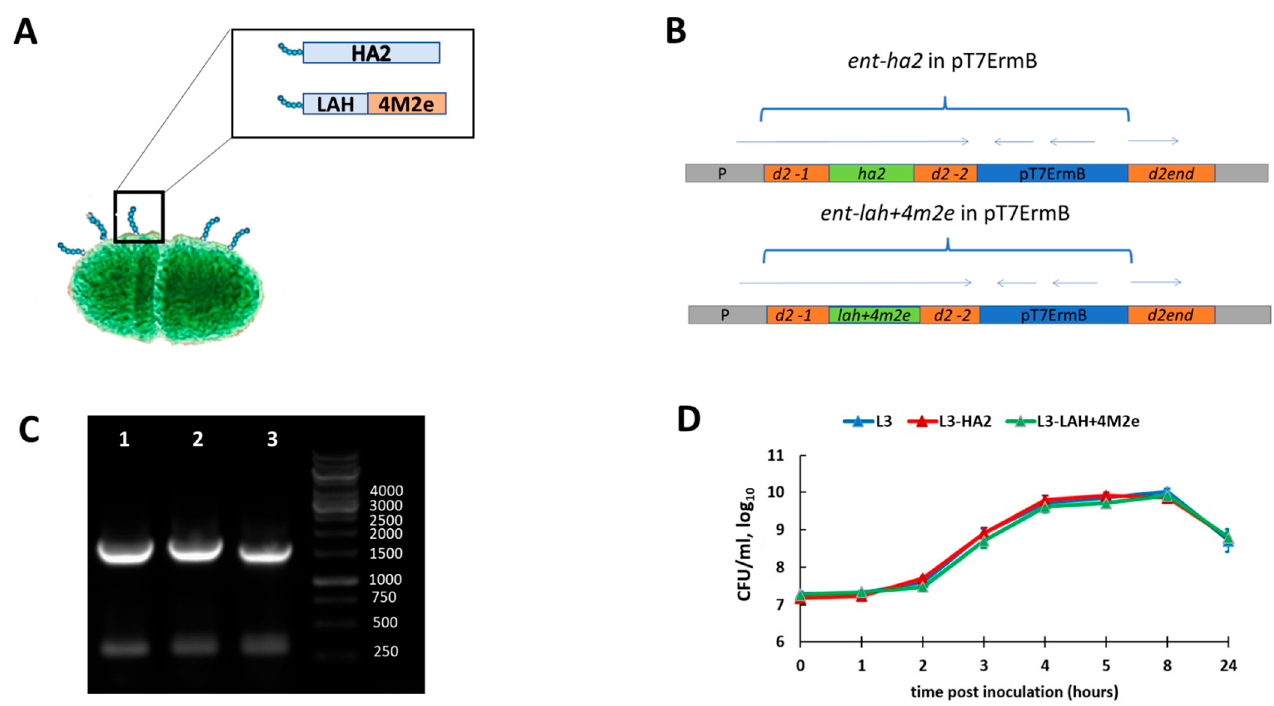
Figure 2. Generation and characterization of the live probiotic influenza vaccine candidates. ( A ) Schematic presentation of the chimeric E. faecium proteins. ( B ) Integration scheme of the plasmid pT7ermB with the ent-(lah+4m2e) into the chromosome of the strain E. faecium L3. P is the promoter of the gene d2; d2-1 is a region of the d2 gene encoding for N-(lah+4m2e) terminal part of D2 protein; d2-2 is a region of the d2 gene encoding for central portion of D2 protein; LAH and LAH+4M2e are DNA fragments encoding conserved influenza virus epitopes; d2-end is the end of the d2 gene encoding for the C terminus of D2 protein; pT7 ErmB is the integrative plasmid. Arrows correspond to the open reading frames in the integrated element. ( C ) Agarose gel electrophoresis of the amplified bacterial gene d2-1 containing inserts of influenza virus gene fragments: 1—L3-HA2; 2—L3-LAH+4M2e; 3—L3. ( D ) Growth properties of the Enterococcus faecium L3 strain and the enterococcal recombinants.